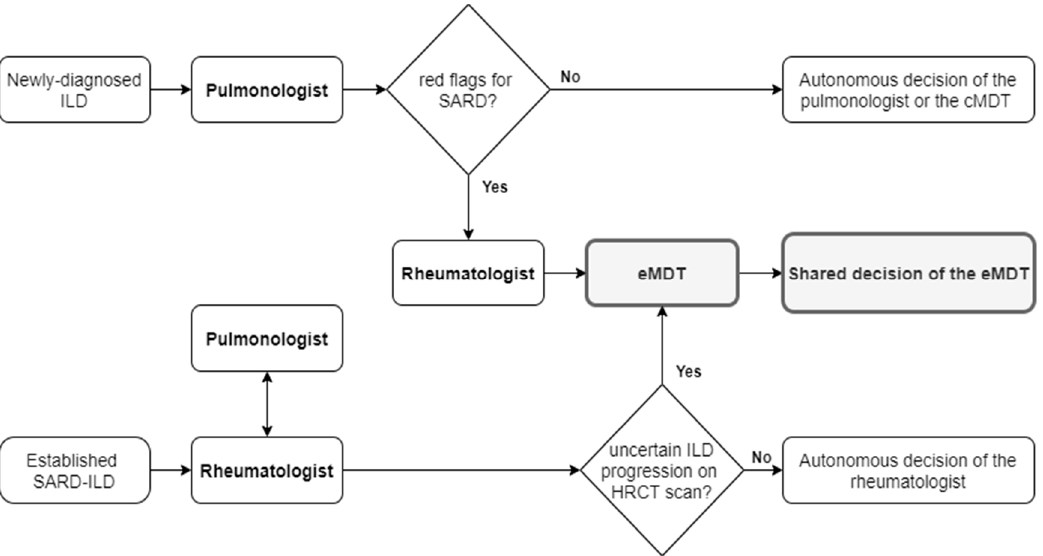
Figure 1. Flowchart of the selection of cases to be discussed at eMDT. ILD: interstitial lung disease; SARD: systemic autoimmune rheumatic disease; cMDT: conventional multidisciplinary team; eMDT: multidisciplinary team extended to rheumatologists; SARD-ILD: interstitial lung disease related to systemic autoimmune rheumatic disease; HRCT: high-resolution computed tomography.